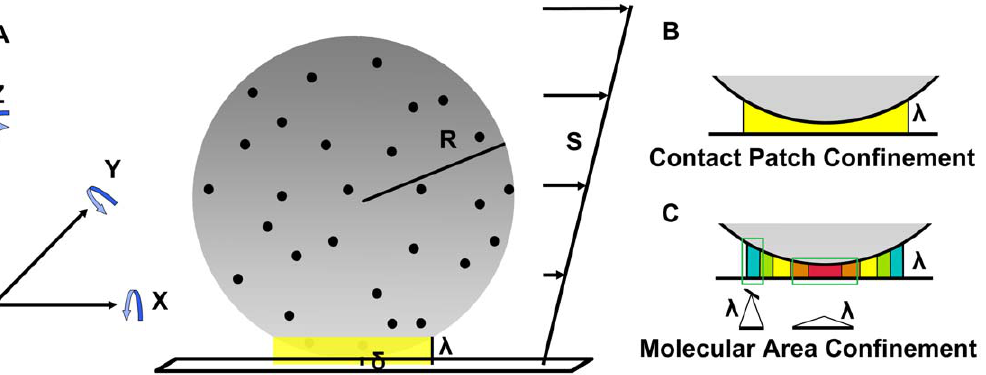
Figure 1. Simulation geometry. (A) A Cartesian coordinate system was employed. Flow was applied in the X-direction with a linear shear rate, S. A three dimensional sphere with a fixed radius, R, was coated with receptors, and each anchor point of the base of the receptor’s tether region to the surface of the sphere is shown as a black dot. Only the receptors within an unstressed receptor/ligand contour length of the surface, l , were allowed to form bonds. This region has been highlighted in yellow. The gap between the base of the sphere and the surface, d , was allowed to vary. The diffusion of the sphere was included in the simulation. The diffusion had six components with the inclusion of rotation in the sphere’s motion. Motion perpendicular to the flow direction, along the Y-axis, is referred to as ‘‘wobble’’ in the text. (B,C) Two different models of reactivity for molecules in the contact volume were included in the simulations. For contact patch confinement, described mathematically by (1), all of the receptors on the sphere within an unstressed receptor/ligand contour length of the surface were assumed to react with a constant rate. For molecular area confinement, described mathematically by (2), receptors immobilized on portions of the sphere closest to the surface were allowed to form bonds with an increased rate proportional to the area of the projection of the molecular contour length onto the XY plane. The colors in (B,C) depict the relative reaction rate of receptors, and warmer colors indicate an increased reaction rate.